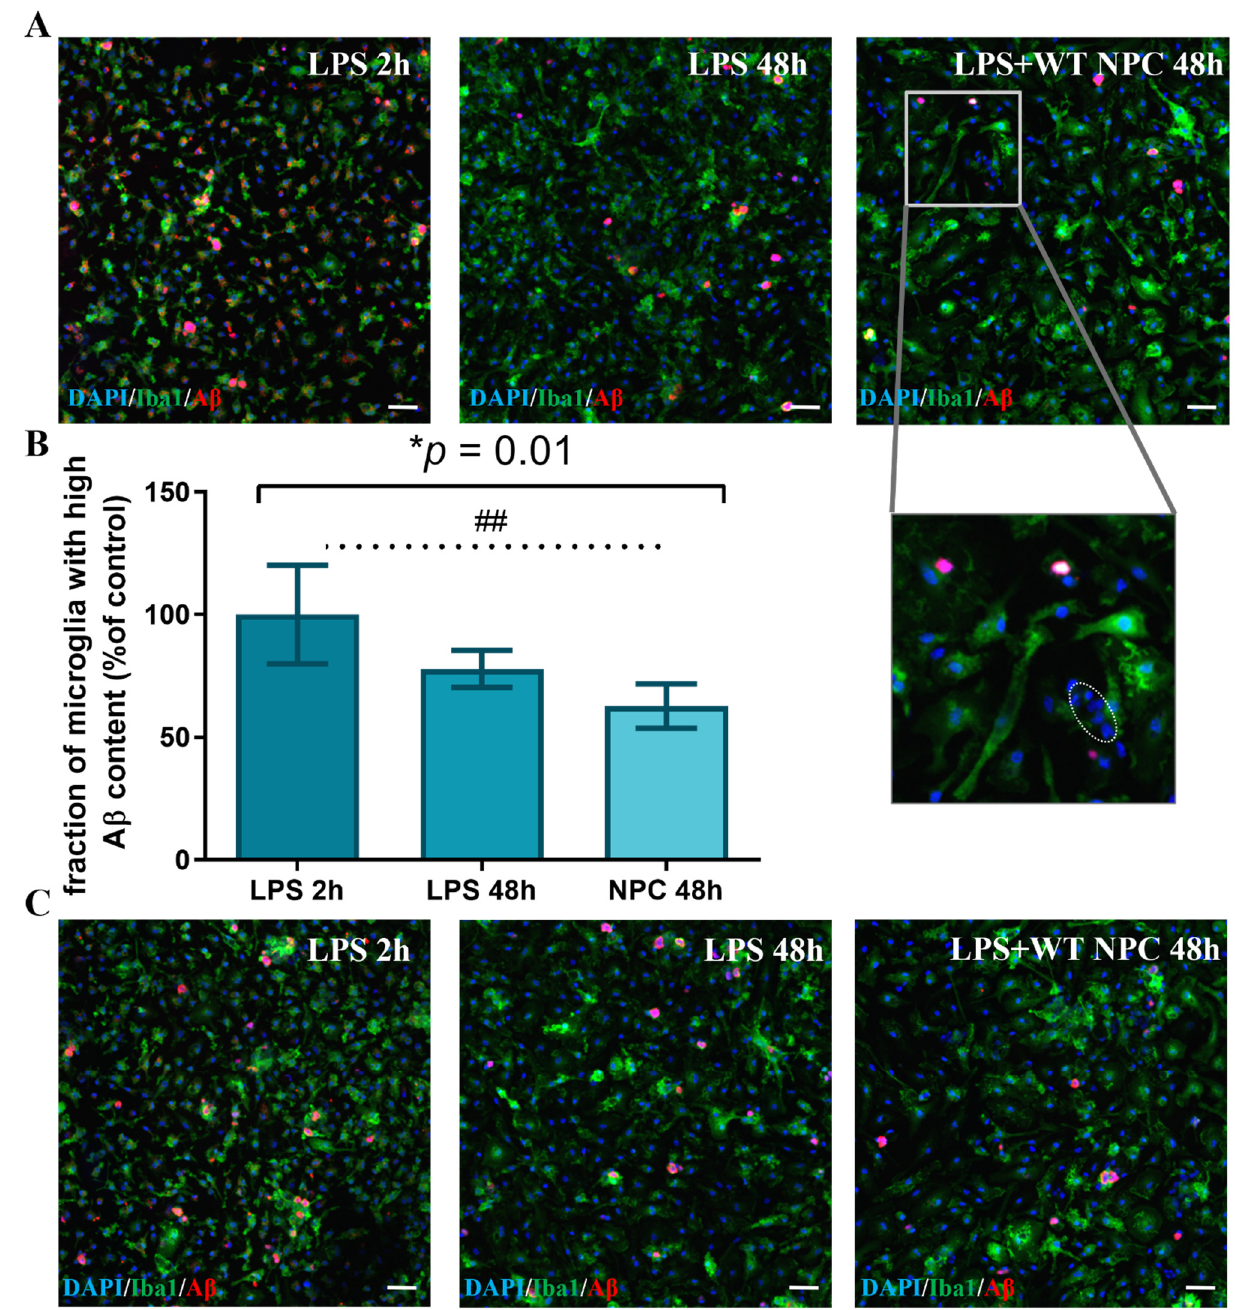
Figure 7. Newborn mouse NPCs promote A β removal in highly phagocytic microglia after 48 h. ( A ) After 48 h, almost no remaining A β was found in microglia with low A β phagocytic activity, with no difference between conditions. Representative images in high exposure show microglia with high and low A β content at the 2 h baseline, while only microglia with high A β content are observed after 48 h in control and NPC-treated cultures. Enlargement in the right panel shows a (circled) Iba1-negative cluster of NPCs. ( B ) Co-culturing A β -loaded 5xFAD microglia with NPCs from WT newborn mice induced a reduction of the fraction of microglia with high A β content after 48 h as compared to control. Baseline fraction of microglia with high A β content (LPS 2 h) served as 100%. One-way ANOVA: * p = 0.01, post hoc analysis indicated that NPCs promote degradation. NPC 48h vs. LPS 2 h: ## p = 0.0087. ( C ) Representative images of microglia with high A β content at the 2 h baseline, and after 48 h in control and NPC-treated cultures. Blue = DAPI, green = Iba1, red = A β , scale = 50 μ M.